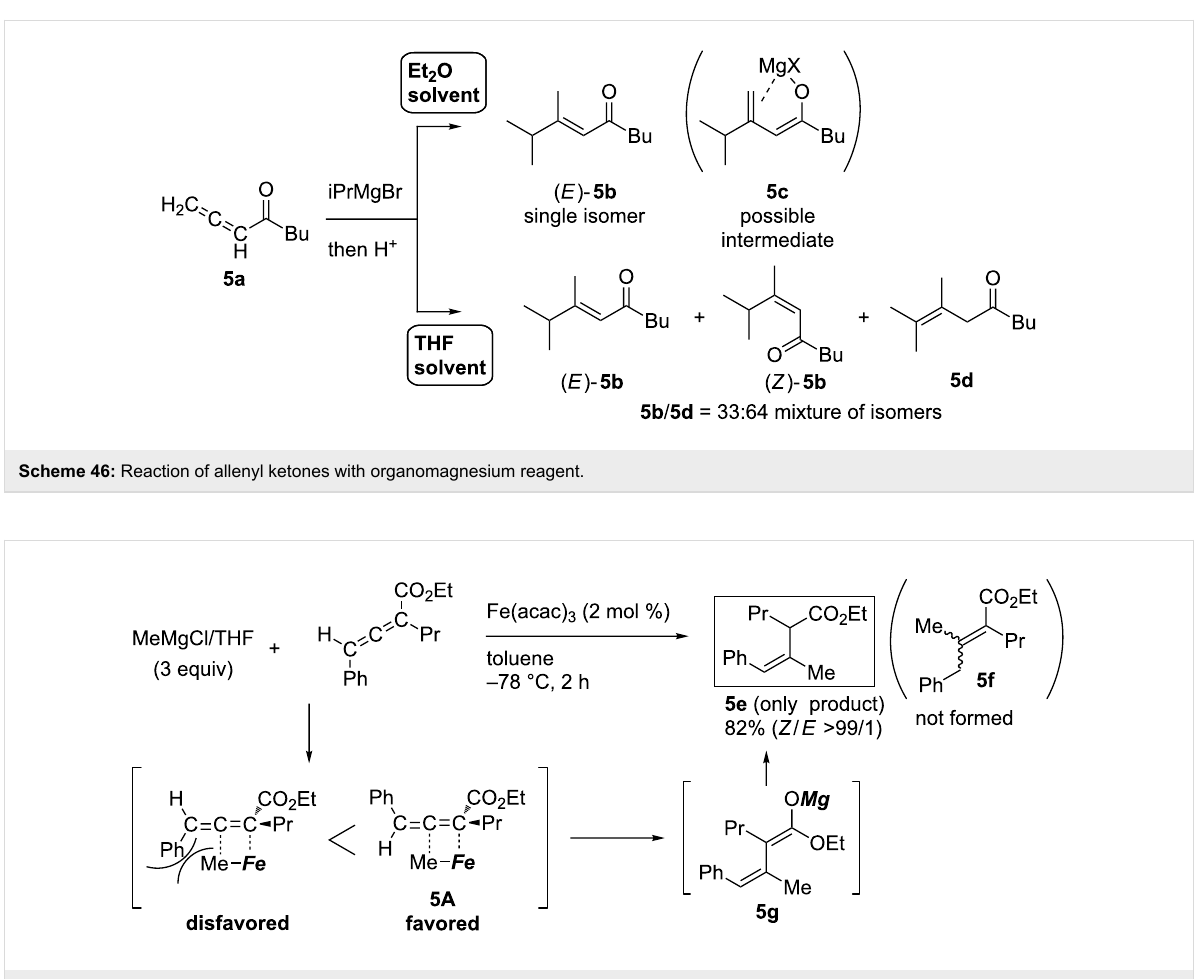
Scheme 47: Regio- and stereoselective reaction of a